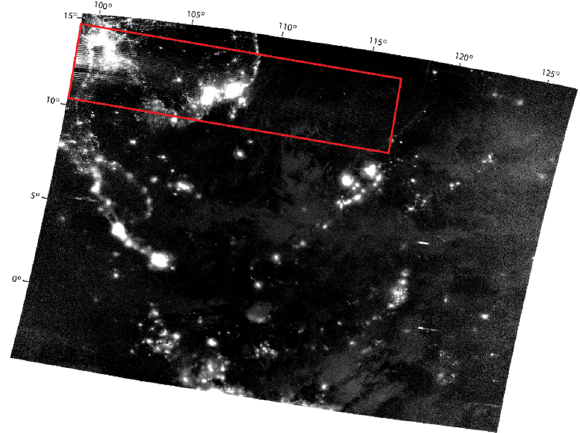
Figure 14. SNPP DNB image from December 28, 2014, 18:06 GMT. The red box indicates the approximated areas with contaminations.